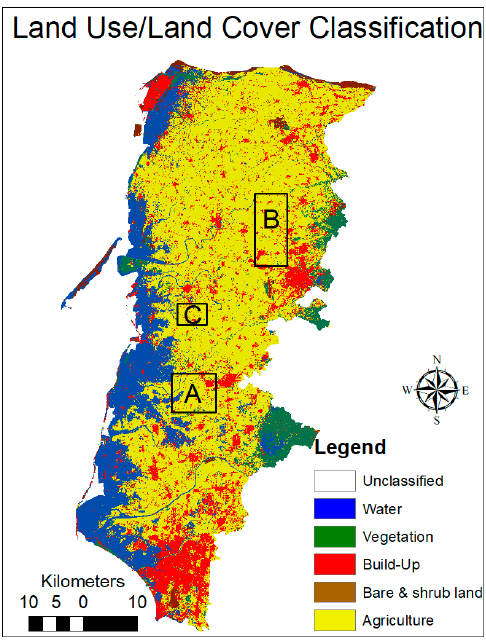
Figure 2. Land use/land cover map over Yun-Chia-Nan, Taiwan, Landsat-8/OLI